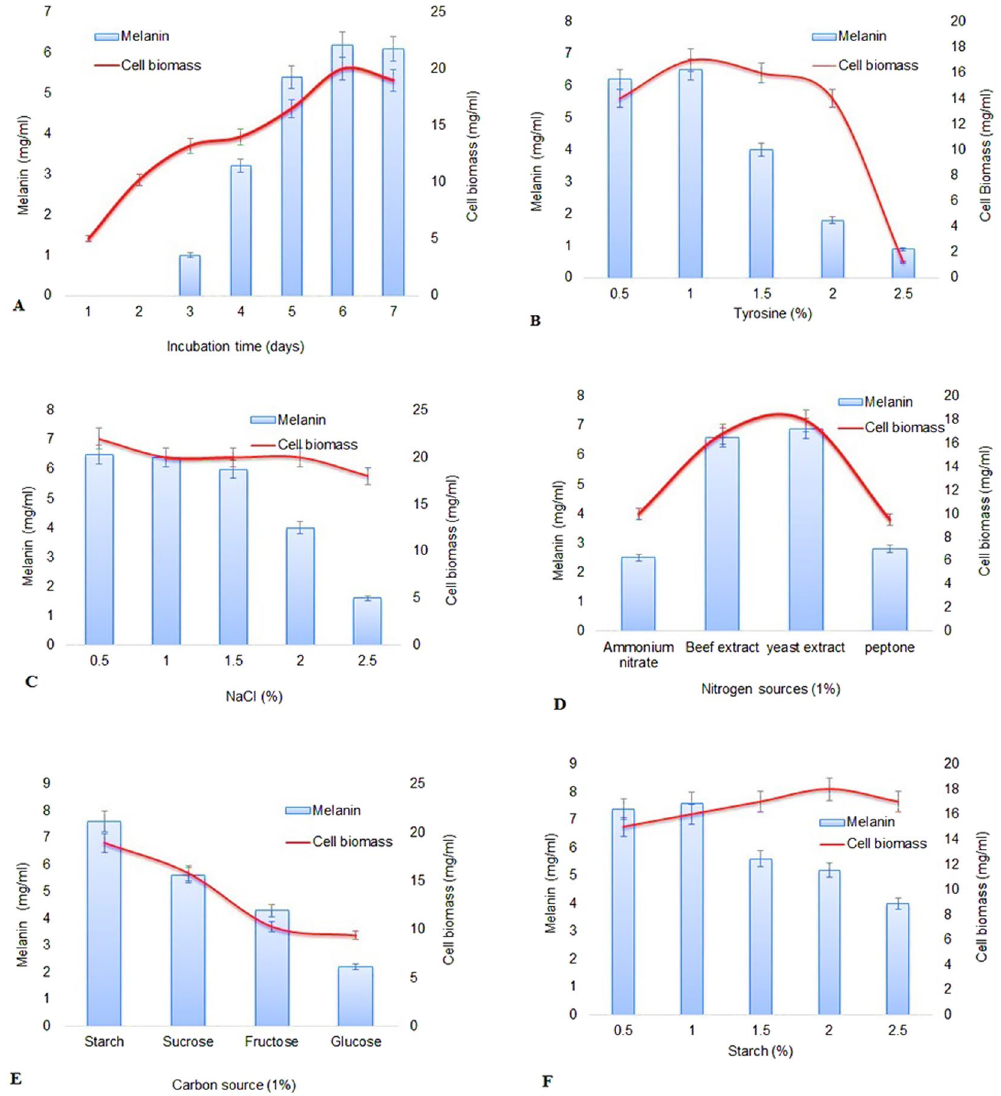
Figure 2. Effect of nutritional factors on cell biomass and melanin production. ( A and B ) Show optimized production of melanin at various incubation times and the effect of tyrosine supplementation in the production media. ( C – F ) Show the effect of supplementation with NaCl and nutritional sources such as nitrogen and